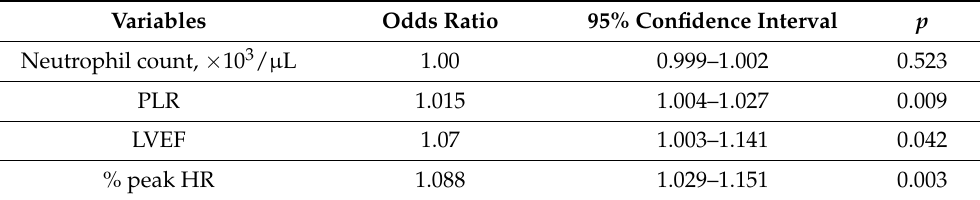
Table 3. Multivariate regression analysis to predict poor functional capacity.